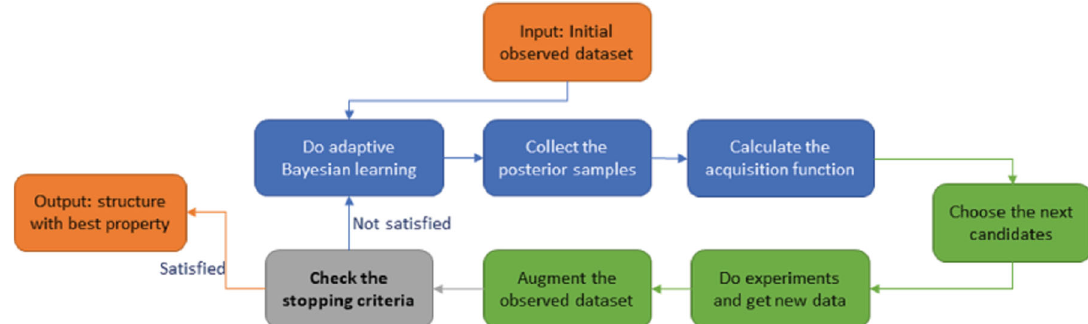
Fig. 5 Work fl ow of the automated experimental design framework. The overall work fl ow of the automated experimental design framework is based on Bayesian optimization with adaptive Bayesian